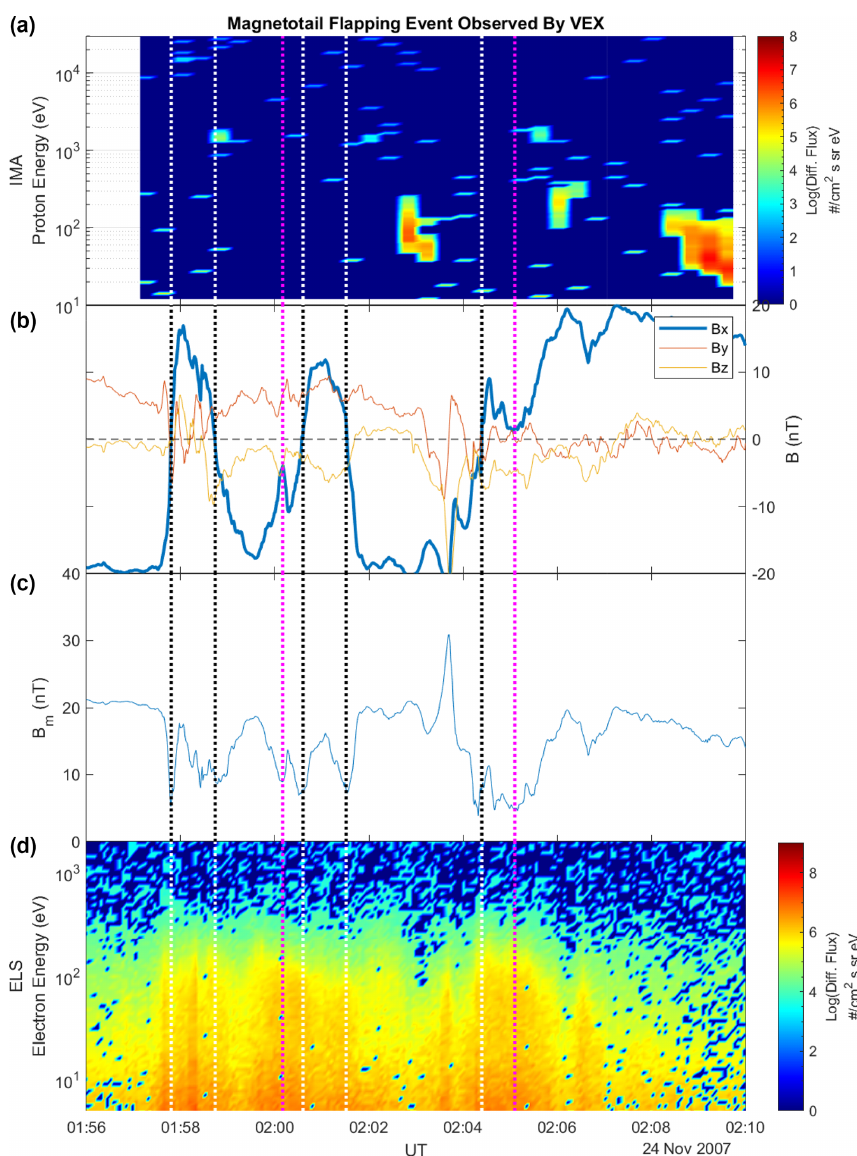
Figure 10. Magnetotail flapping event at Venus in the near tail near ∼ ( − 1 . 5 , 0 . 1 , 0 . 5 ) observed by Venus Express on 24 November 2007 (see also Rong et al., 2015). Panel (a) shows the proton differential flux time–energy spectrogram. Panel (b) shows the three components of the magnetic field. B x is in a thick blue line showing how it oscillates over the spacecraft moving VEX from one lobe to the other. Panel (c) shows B m with clear dips when B x = 0nT. Panel (d) shows the electron differential flux time–energy spectrogram. The white/black vertical dotted lines show the B x = 0nT crossings, where magenta lines show times when B x approaches but does not reach